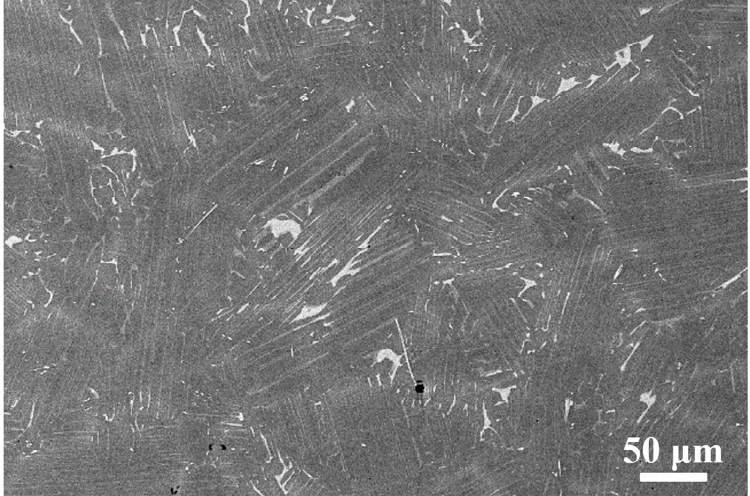
Figure 9. The microstructure of the as-cast alloy. Metals 2018 , 8 , x FOR PEER REVIEW